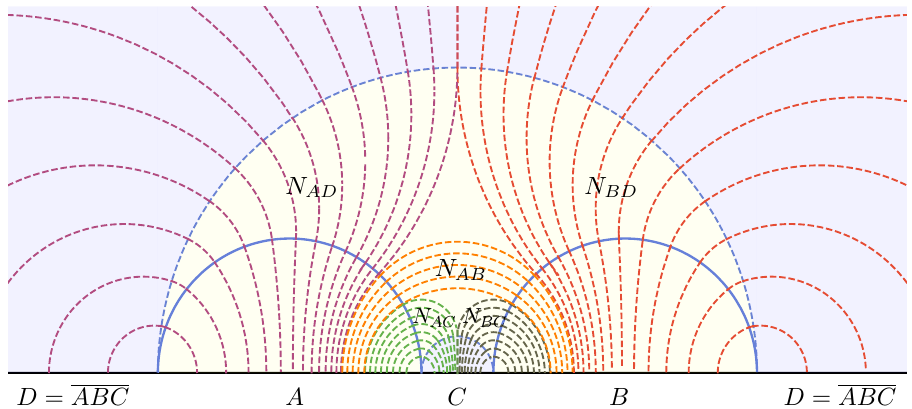
Figure 11 . In this (cid:12)gure we represent in di(cid:11)erent colors the individual thread bundles of the max multi(cid:13)ow con(cid:12)guration connecting the various regions in in a system of two disjoint intervals. The threads connecting the regions A and B are labeled as N AB , A and C as N AC , A and D as N AD , B and C as N BC , and B and D as N BD . The threads that connect A and B have the physical meaning of representing half the mutual information between A and B , I ( A : B